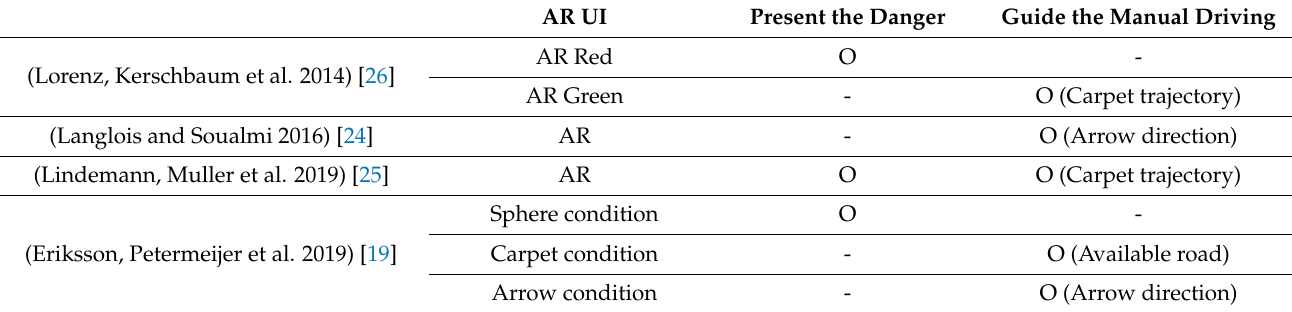
Table 5. Augmented reality (AR)